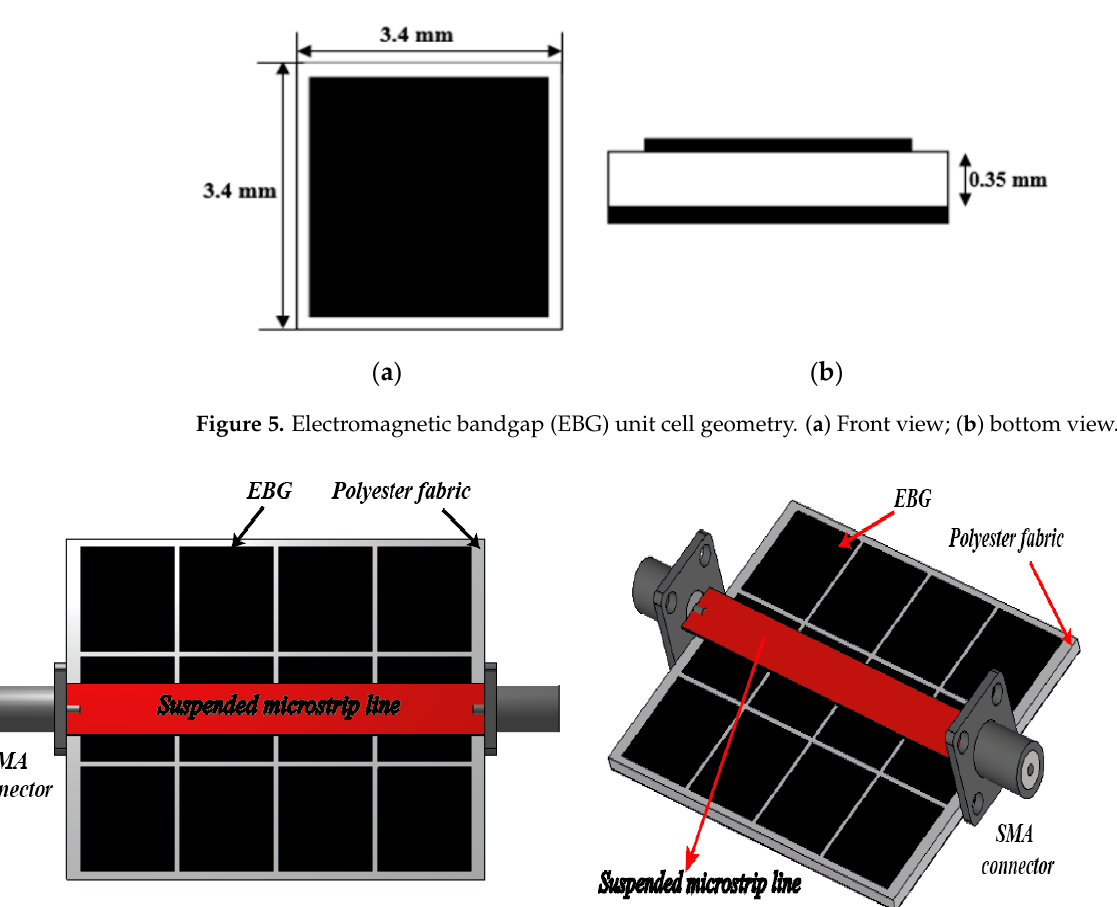
Figure 5. Electromagnetic bandgap (EBG) unit cell geometry. ( a ) Front view; ( b ) bottom view.